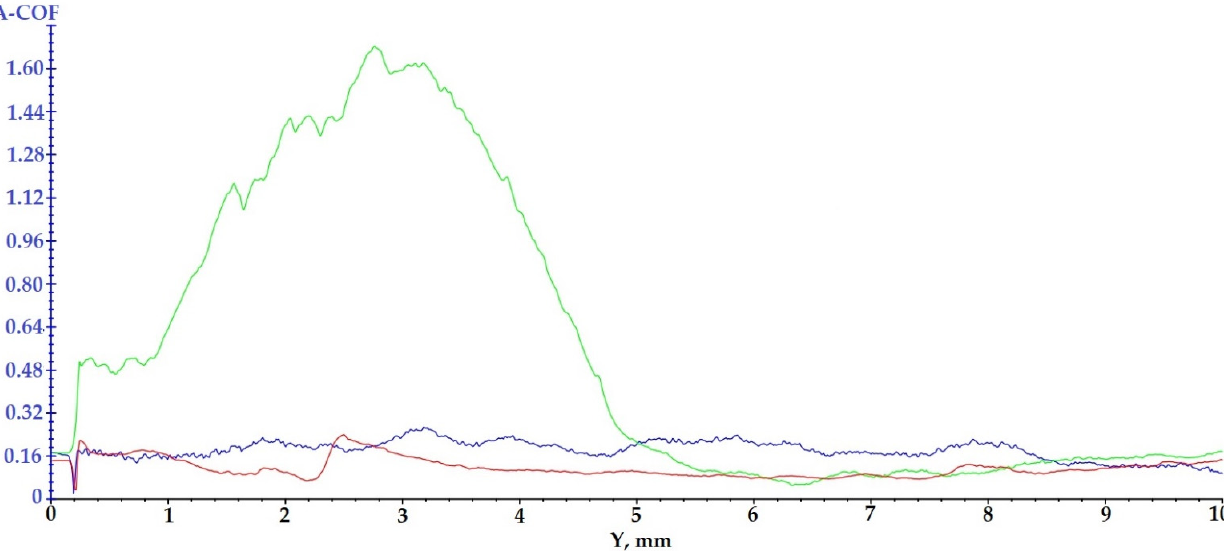
Figure 8. Results regarding the scratching behavior of the samples coated with ceramic layers: blue curve—P3–143–9 passes; green curve—P6–6420–9 passes; red curve—P9–136–9 passes.